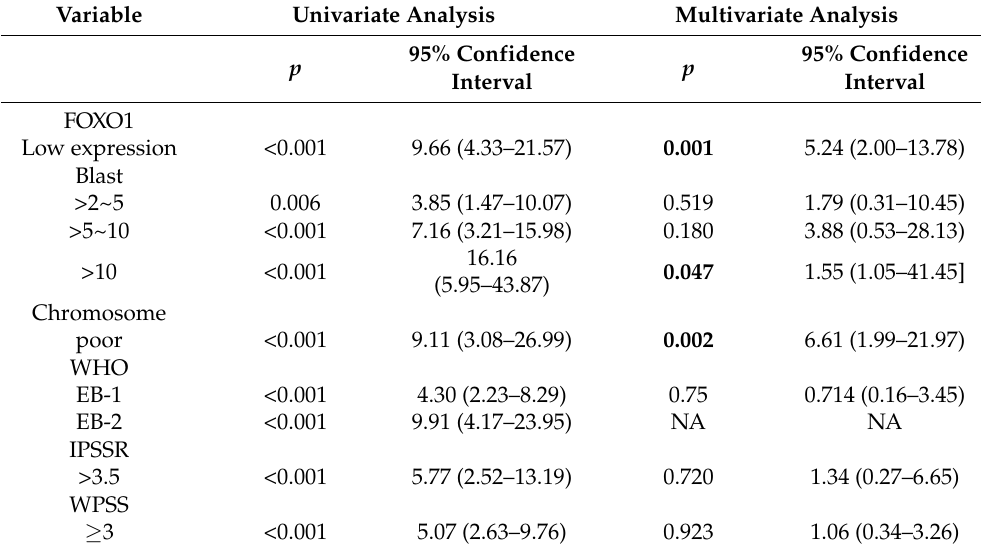
Table 3. Cox regression univariate and multivariate analyses of PFS factors in MDS.